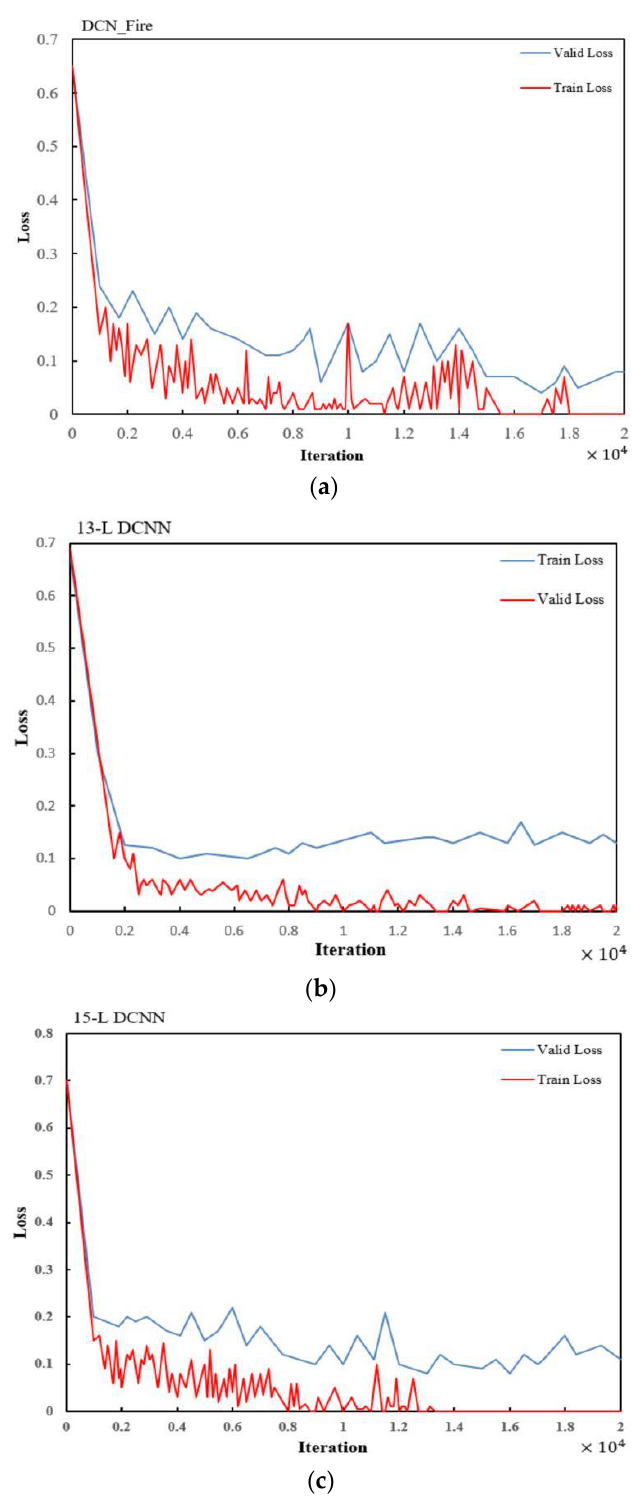
10 of 16 Figure 5. Flame image processing time comparison of the DCN_Fire model and 13-layer, 15-layer, and 20-layer DCNN models. Although the 20-layer DCNN model achieved a verification accuracy similar to that of the DCN_Fire model (0.983), its processing time was 1.67 longer due to the larger number of layers, increasing the calculation time and cost. Therefore, the DCN_Fire model was superior in terms of processing time and verification accuracy. Meanwhile, the original and enhanced image data sets were used to evaluate the impact of data en- hancement on model accuracy. The data revealed that the verification accuracy of the